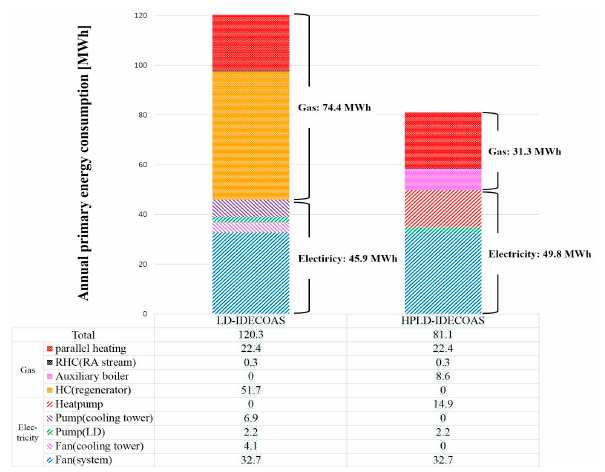
Figure 12. Annual primary energy consumption comparison.